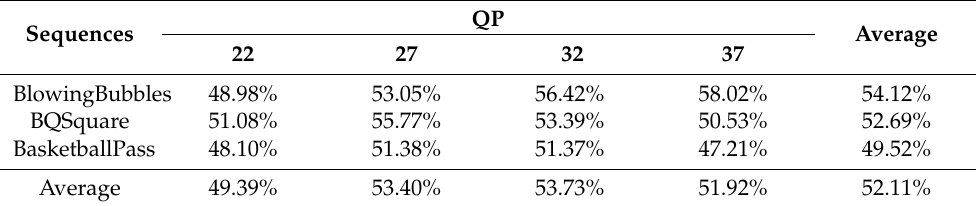
Table 6. Fraction of modes skipped by proposed